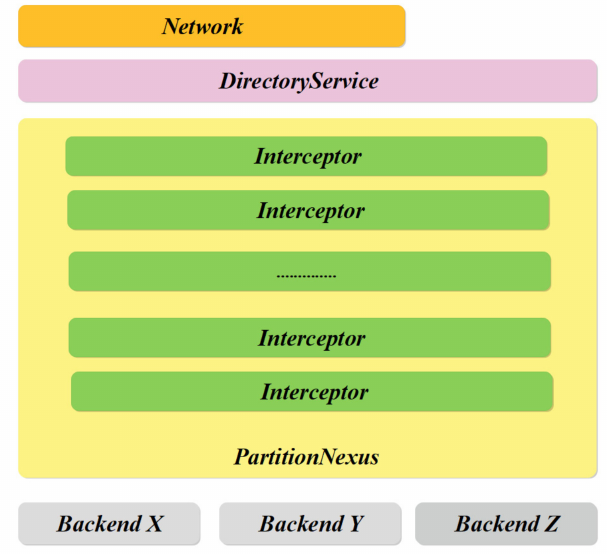
Figure 5. Architecture implementation of the Client Server for duplex communication [16]: Single request and a single reply (HTTP protocol), a Server-Sent Event (SSE), and web socket (WS).